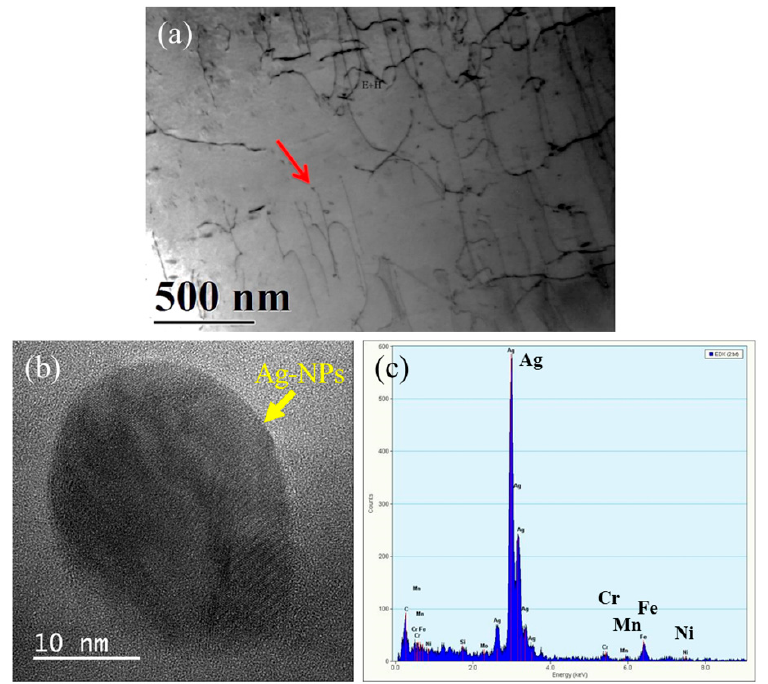
Figure 3. TEM micrographs taken from the 2205Ag after 450 °C aging treatment for 1 h. ( a ) BF image showing some fine precipitates (red arrow) within the austenite phase, ( b ) HR-TEM image of an Ag-NP, showing that the diameter of Ag-NPs was about 15 nm; and ( c ) EDS analysis results for the Ag-NP.